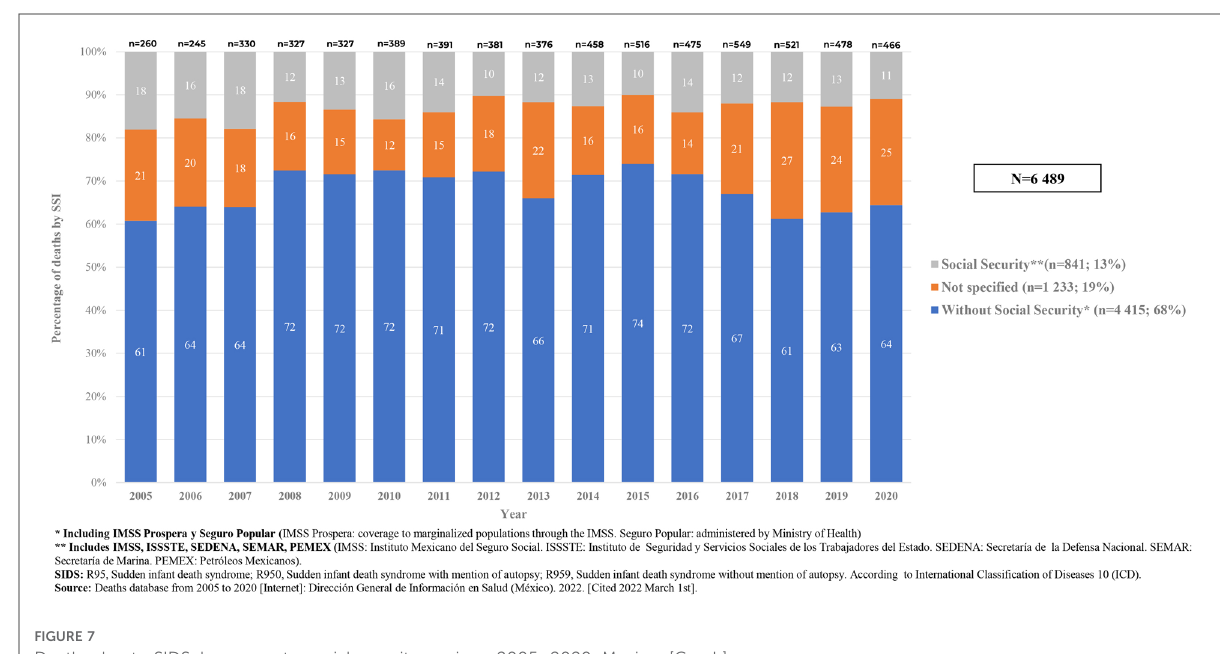
FIGURE 7 Deaths due to SIDS, by access to social security services, 2005 – 2020, Mexico.